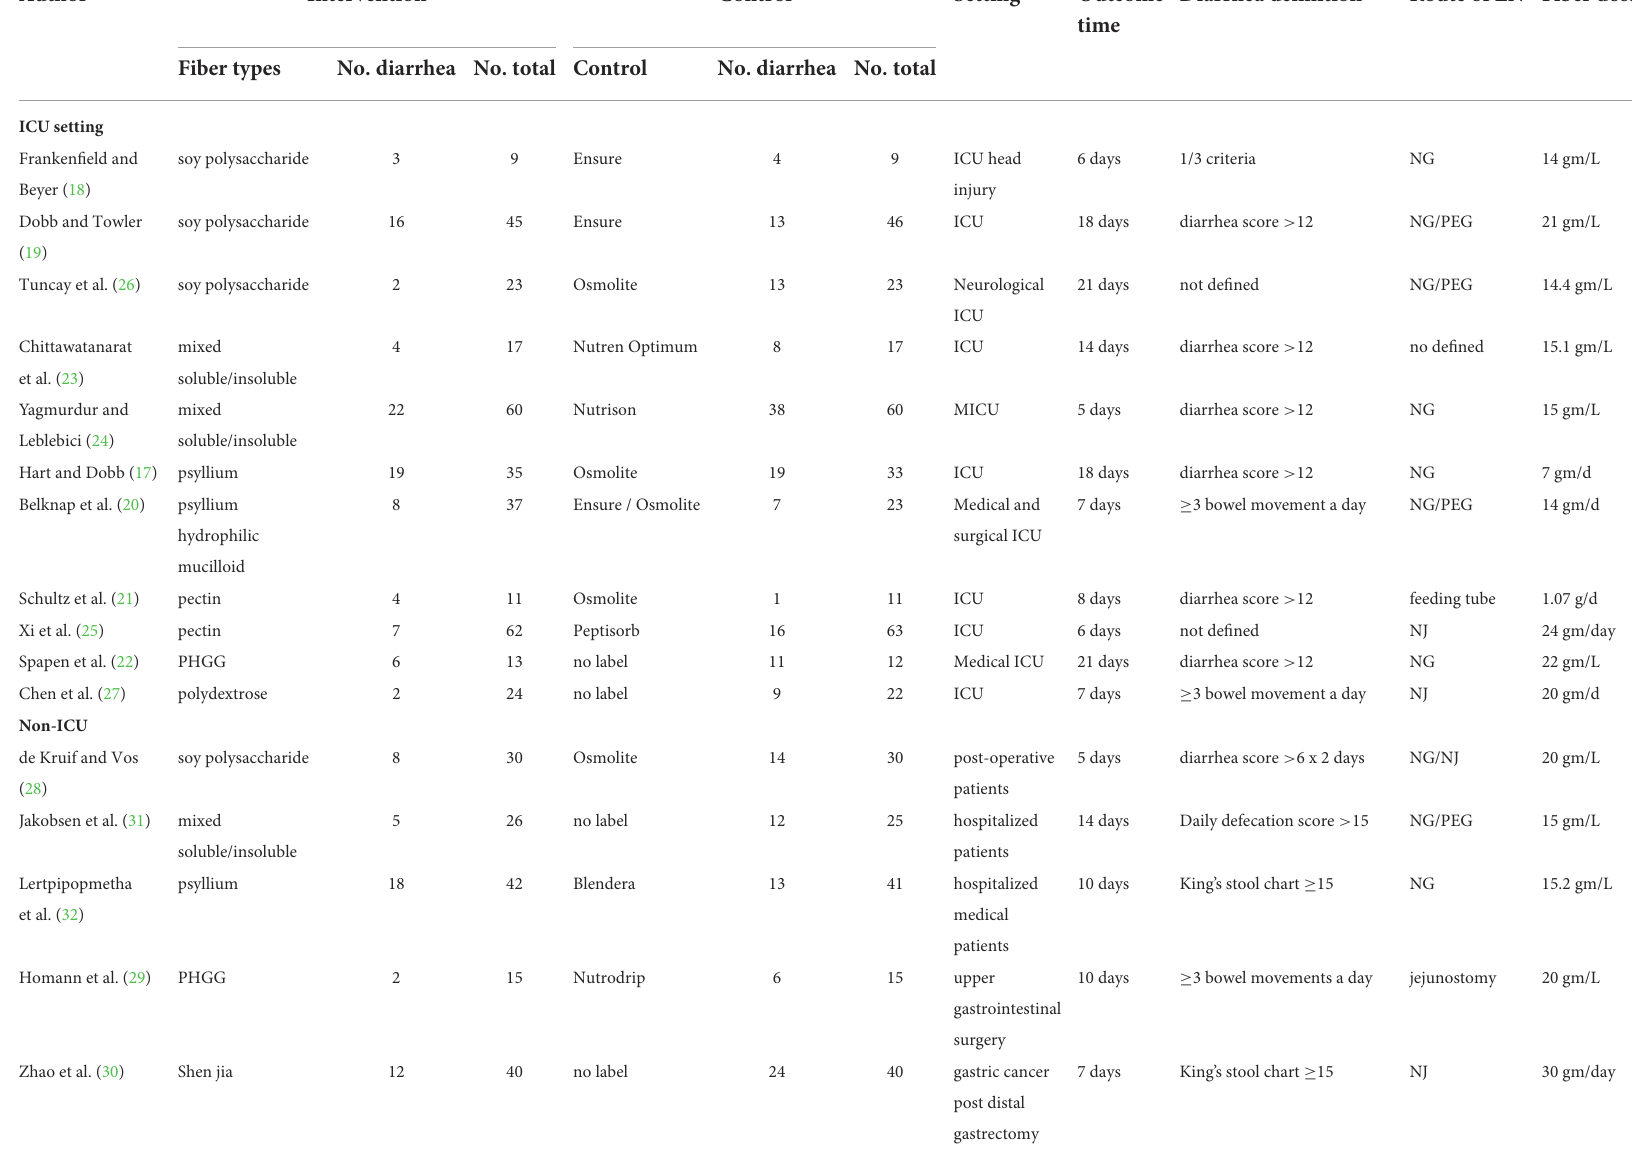
TABLE 1 Characteristics of included randomized controlled trials